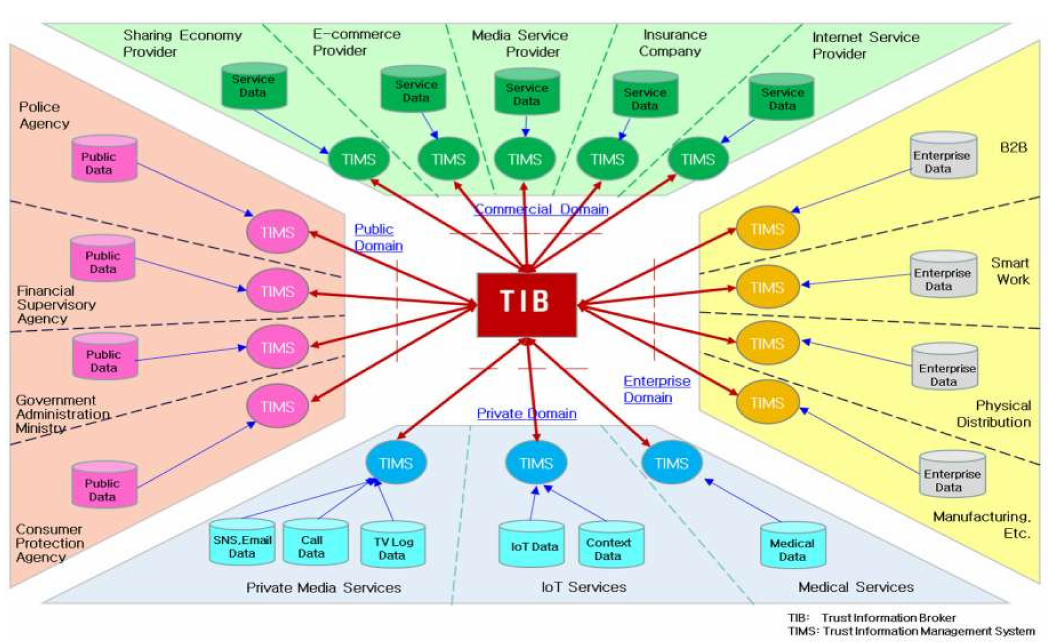
Figure 7. An example of trust information broker